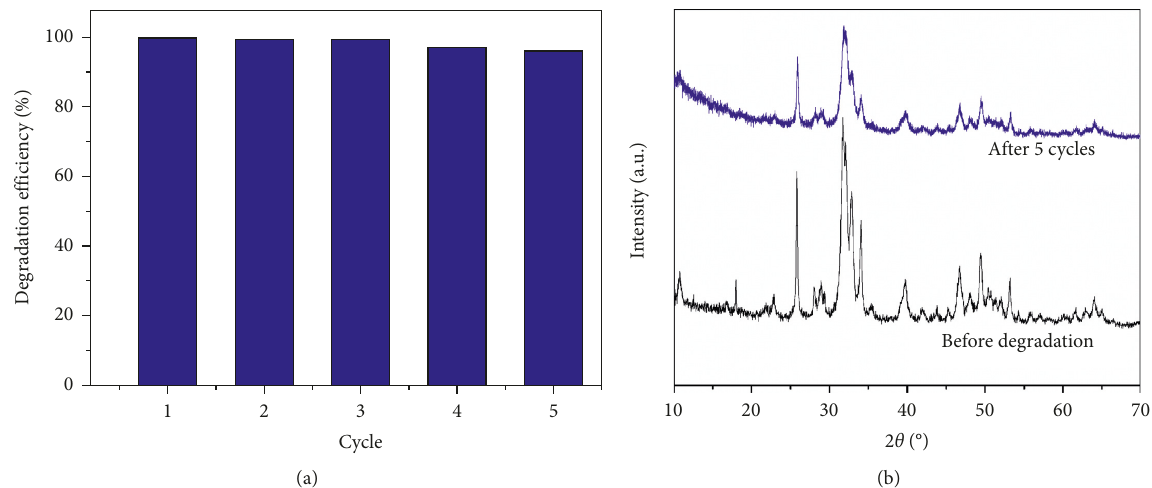
Figure 8: Degradation efficiency reduction (a) and the change of XRD pattern (b) of Zn-HA after for continuous